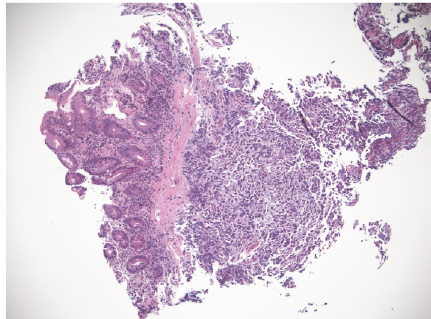
Figure 1: Ulcerated friable duodenal mass noted on esophagogas- troduodenoscopy.